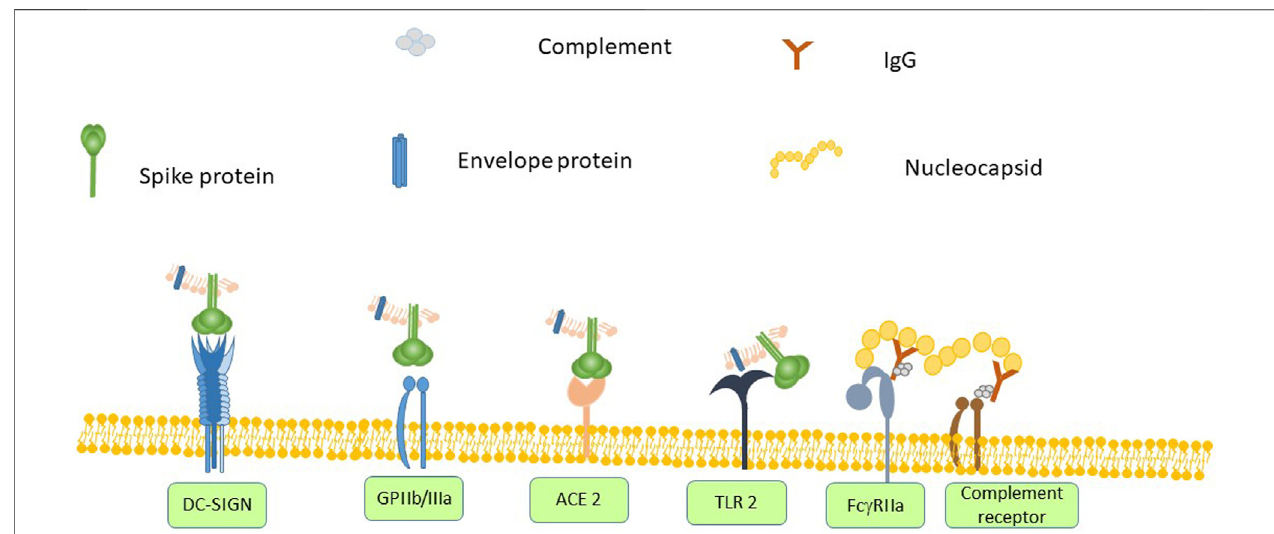
FIGURE 1 | SARS-CoV-2 spike protein binds to angiotensin converting enzyme (ACE) 2 on any cell that expresses it, which includes platelets. Other platelet receptors canalsointeractwithSARS-CoV-2virions.Spike protein containsthe aminoacidsequence RGD, whichwould allow ittobindtoGPIIb/IIIa and italso bindsto DC-SIGN. The envelope protein can bind to Toll-like receptor (TLR)-2. Anti-SARS-CoV-2 antibodies can bind to Fc γ RIIa. Anti-nucleoprotein antibodies can also assemble complement, which in turn binds to a complement receptor on platelets. The combination of activating all of these receptors leads to platelet activation, secretion and ultimately thrombus